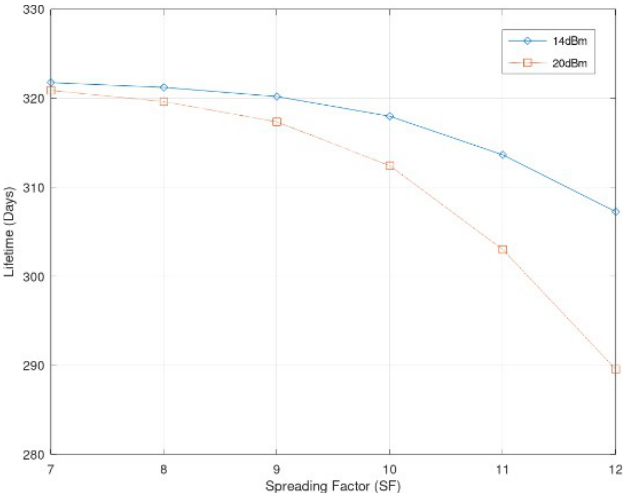
Fig. 7. Power consumption by the operations individually.